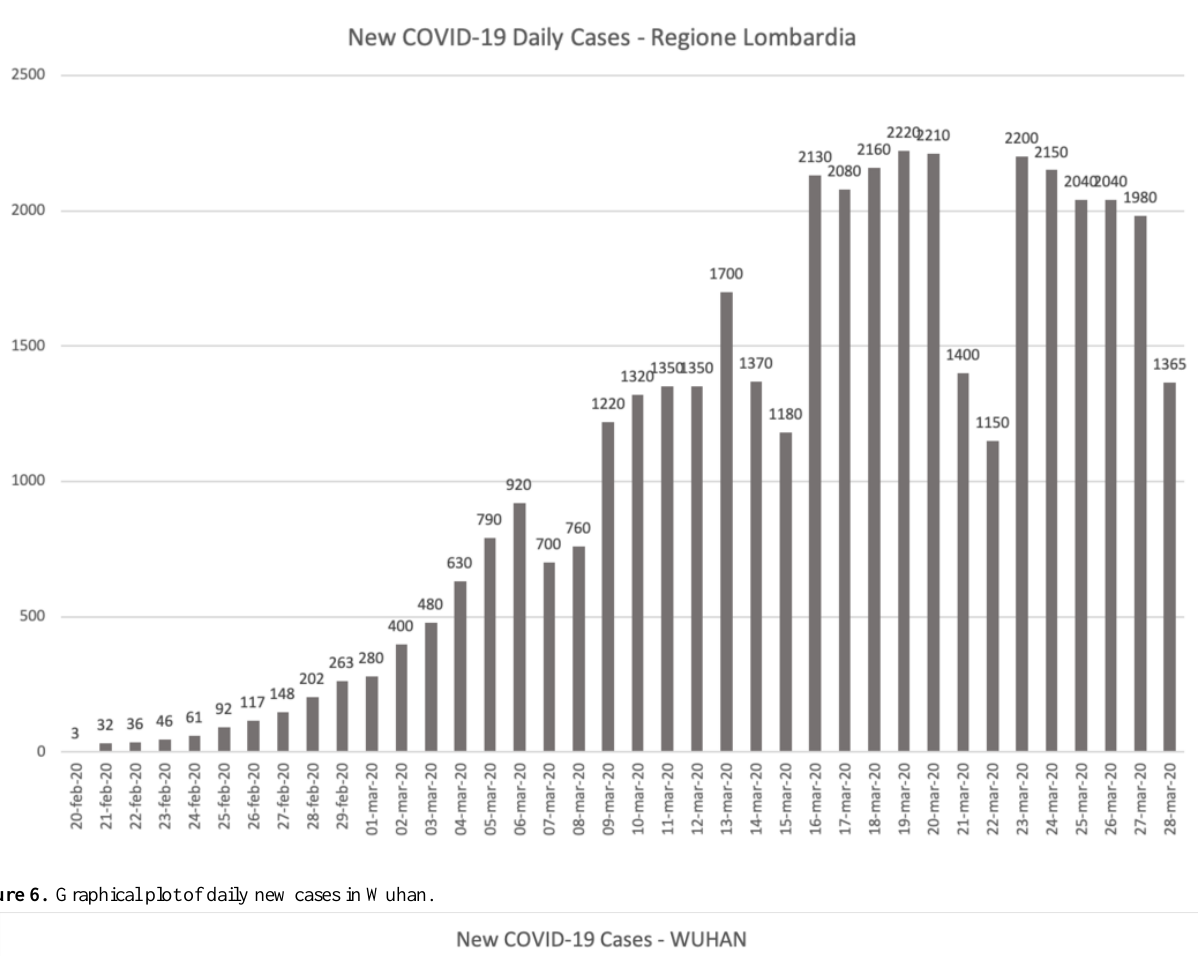
Figure 5. Graphical plot of daily new cases in the Lombardy Region.